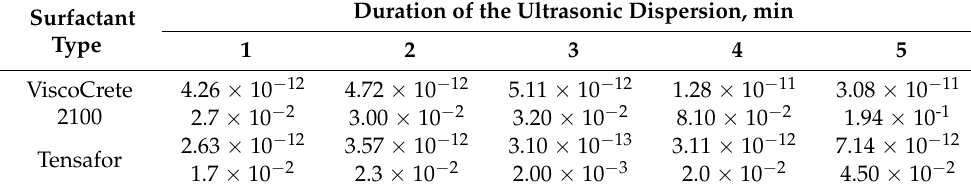
Table 9. Specific sedimentation flow and sedimentation rate in the system “CNPLUS–surfactant–